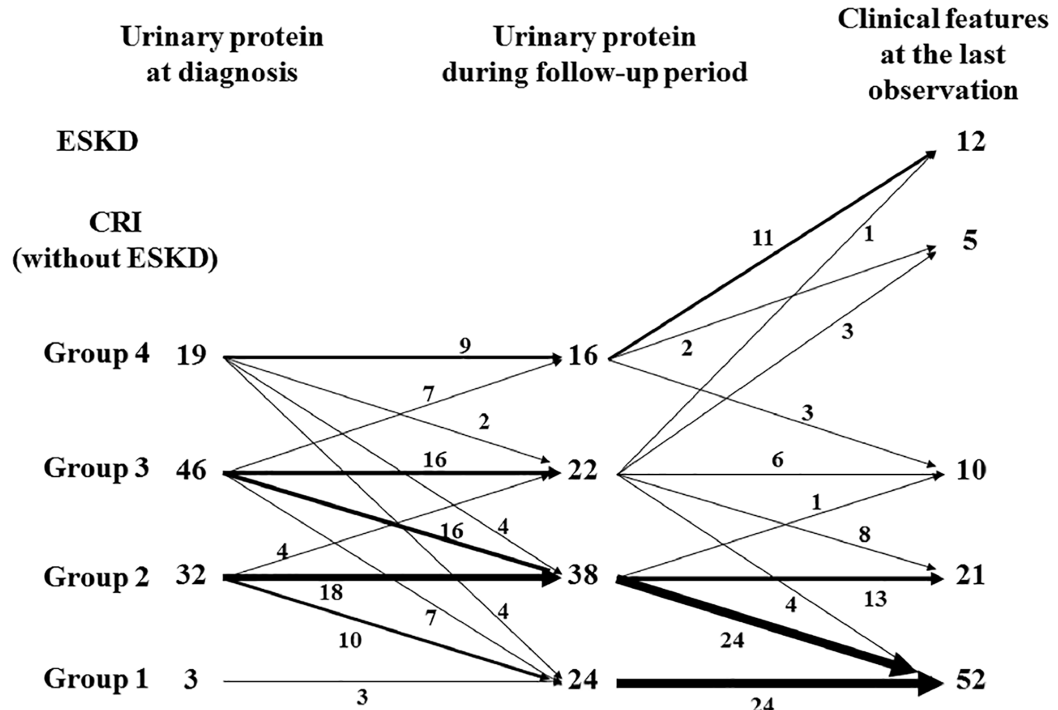
Fig 5. Clinical course of all patients. Group 1, no proteinuria ( < 0.2 g/day/1.73 m 2 ); group 2, mild proteinuria (0.2 – 1.0 g/day/1.73 m 2 ); group 3, heavy proteinuria without hypoalbuminemia ( > 1.0 g/day/1.73 m 2 with serum albumin level (cid:1) 3.0 g/dL); group 4, heavy proteinuria with hypoalbuminemia ( > 1.0 g/ day/1.73 m 2 with serum albumin level < 3.0